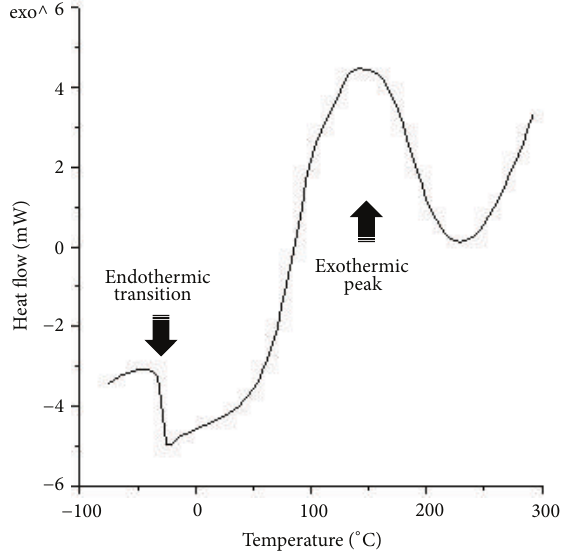
Figure 4: DSC scan of uncured epoxy-titania composition (ET-10): endothermic and exothermic transitions are clearly visible.